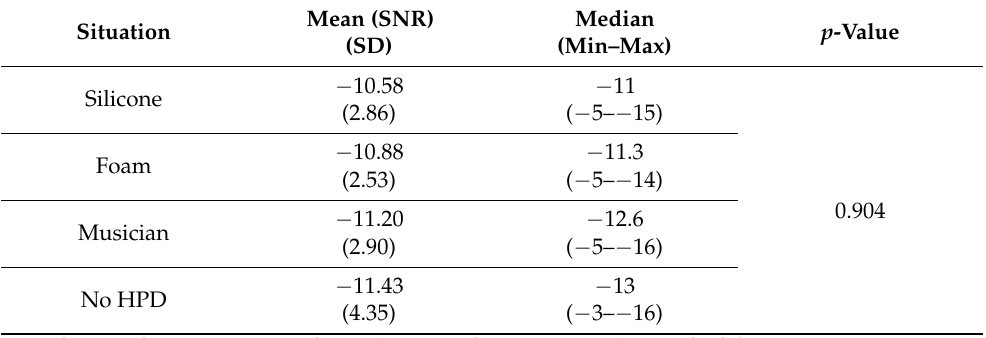
Table A3. Signal-to-noise ratio in sentence recognition with and without HPD.